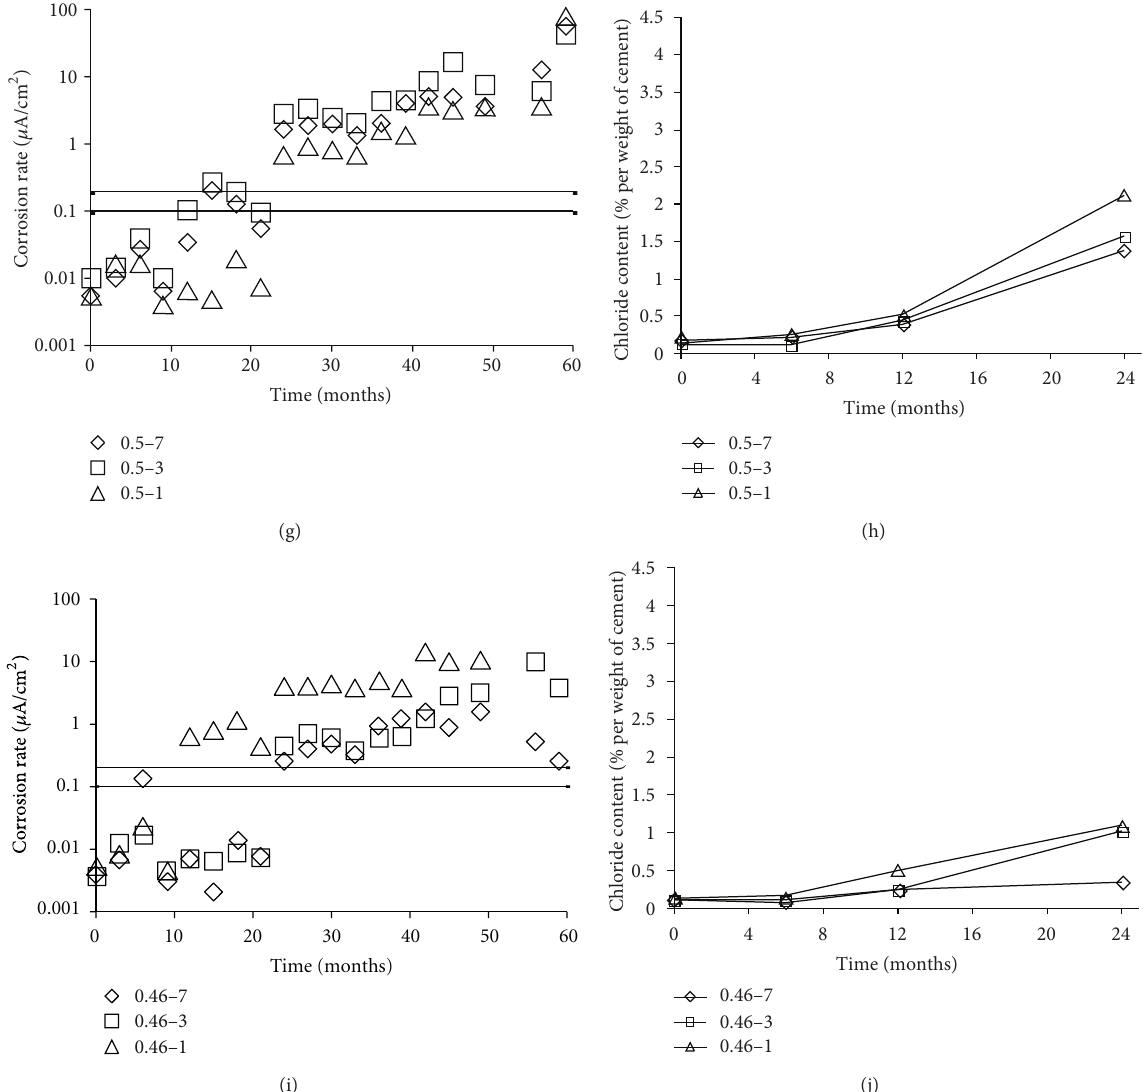
F 3: Instantaneous corrosion rate versus chloride content beside rebars for each of the w/c ratios and times of curing tested.